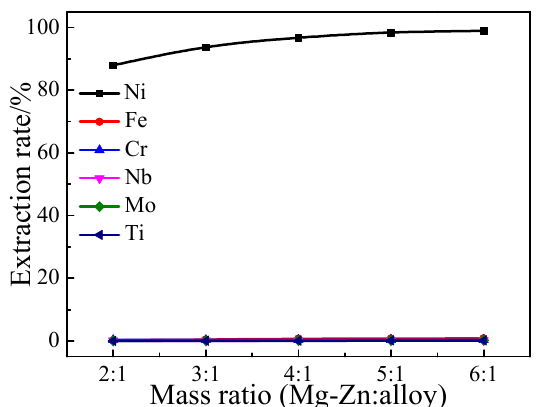
Figure 10. Effect of the mass ratio of Mg-Zn to superalloy on the extraction of metals (Note: the curves for Fe, Cr, Nb, Mo and Ti are overlapping).